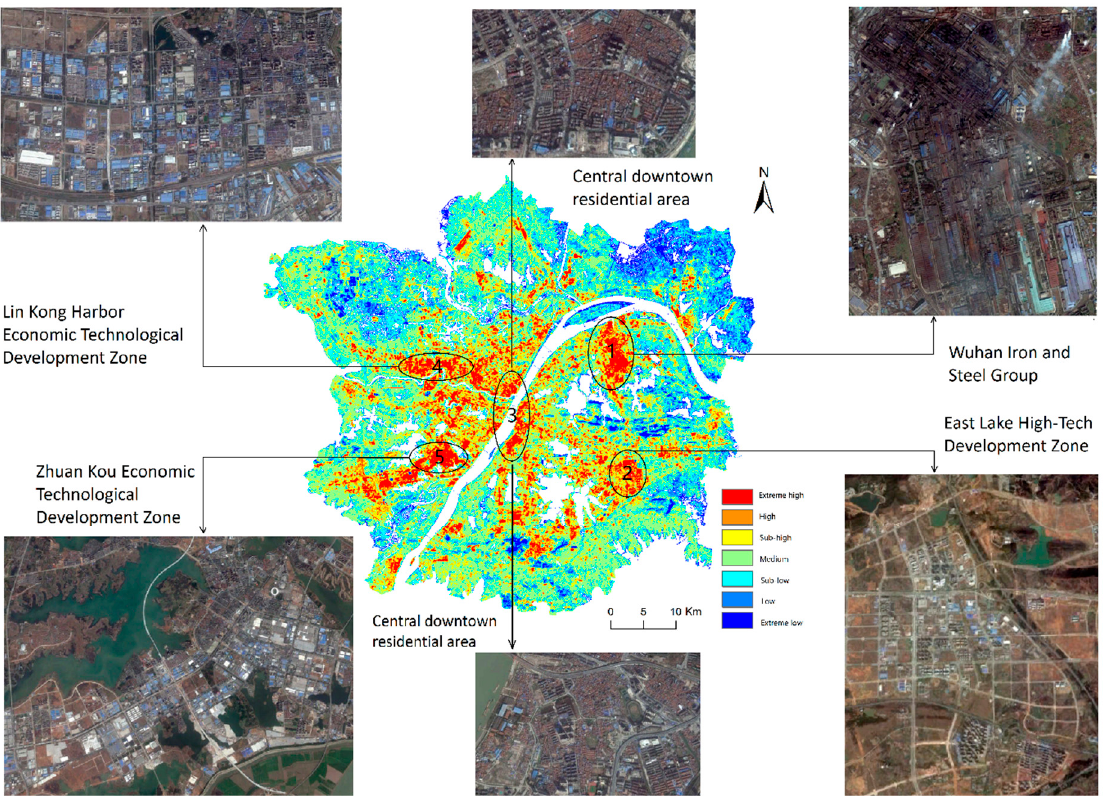
Figure 5 . The aggregation sketch map of Wuhan SUHIs (based on the 2014 image). Figure 5. The aggregation sketch map of Wuhan SUHIs (based on the 2014